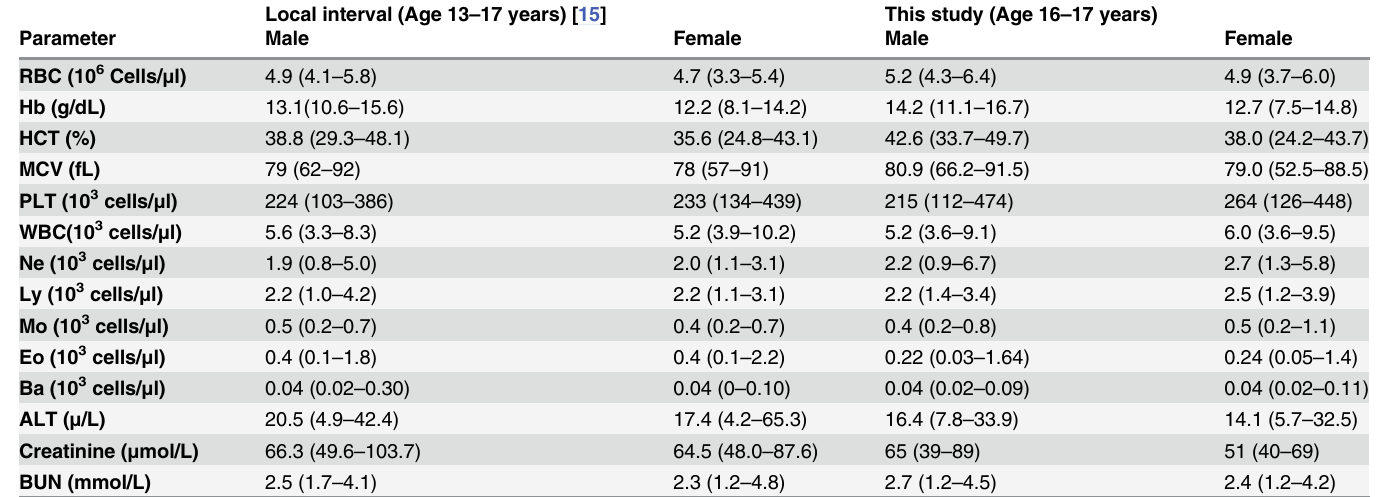
Table 2. Adolescent hematological and biochemistry reference values (median and 95 th -percentile) comparison between locally-established refer- ence intervals for western Kenya versus reference values established from the Kisumu Incidence cohort study in western Kenya (2007 – 2010).